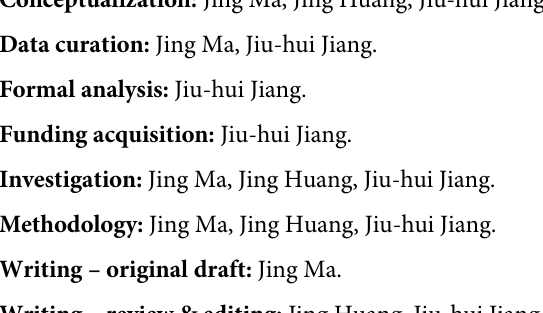
S1 Table. Intra examiner correlation